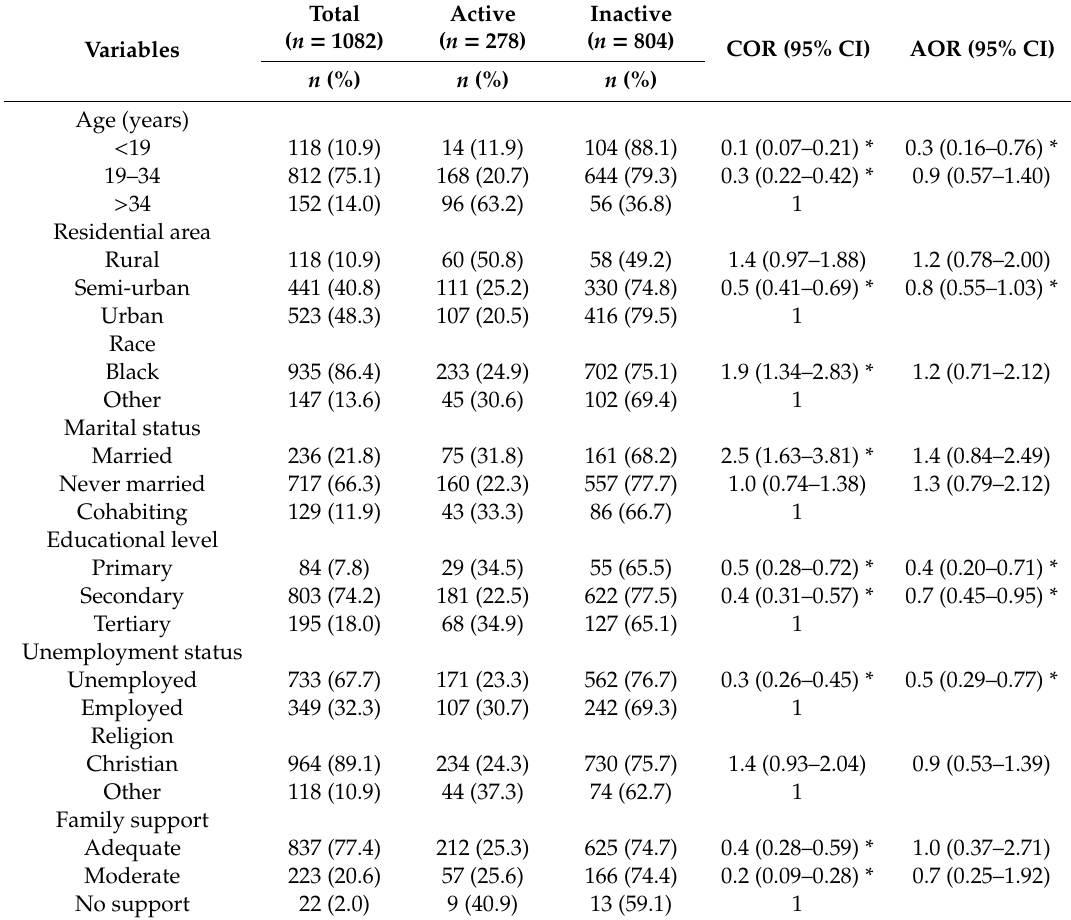
Table 4. Multivariate logistics regression model of physical activity on sociodemographic